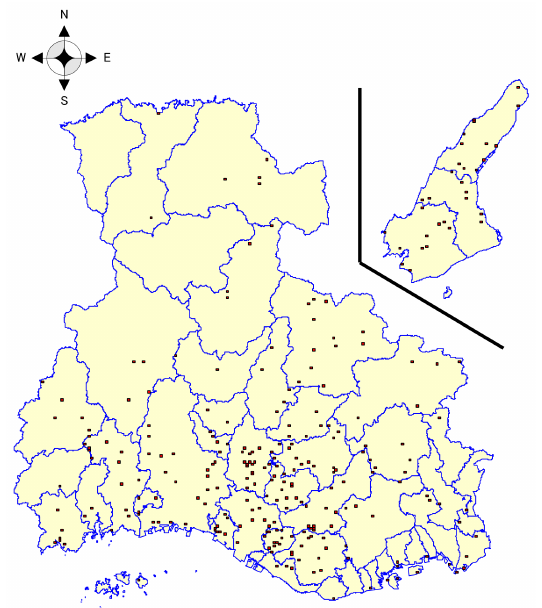
Figure 8. Mega PV solar plant locations in Hyogo Prefecture,